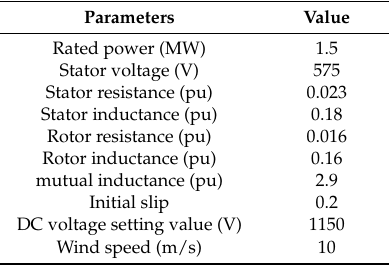
Table 1. Simulation parameters.